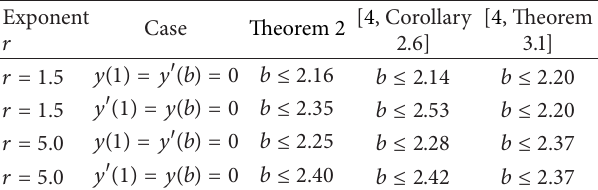
Table 2: Comparison of upper bounds for 𝑏 in Example 13.